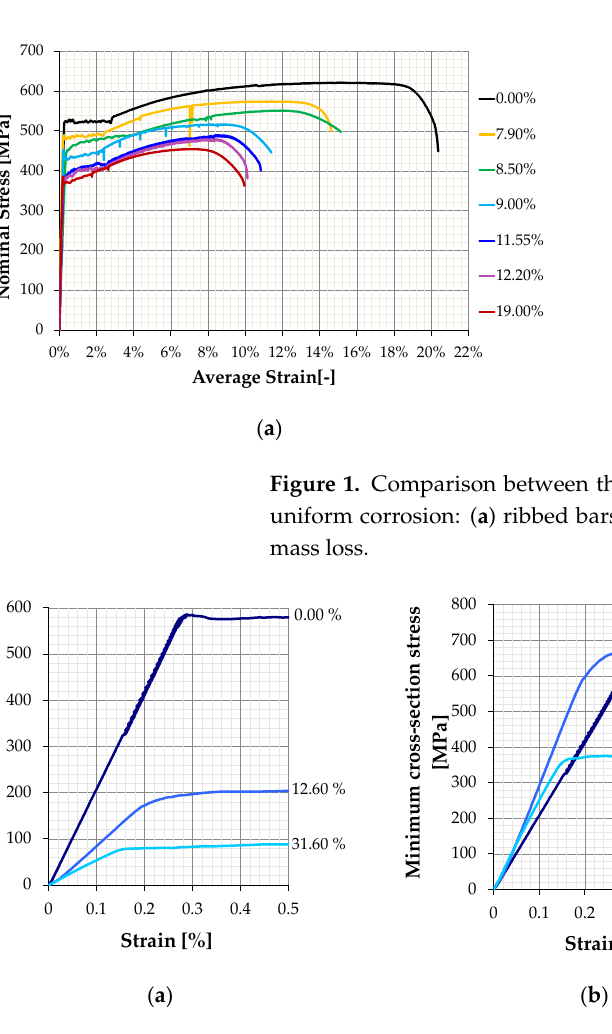
Figure 2. Local constitutive laws referred to the most corroded zone: ( a ) stress evaluated by considering the nominal cross section, ( b ) stress evaluated by considering the most corroded cross section, and ( c ) stress evaluated by considering the average cross section in the gauge length.